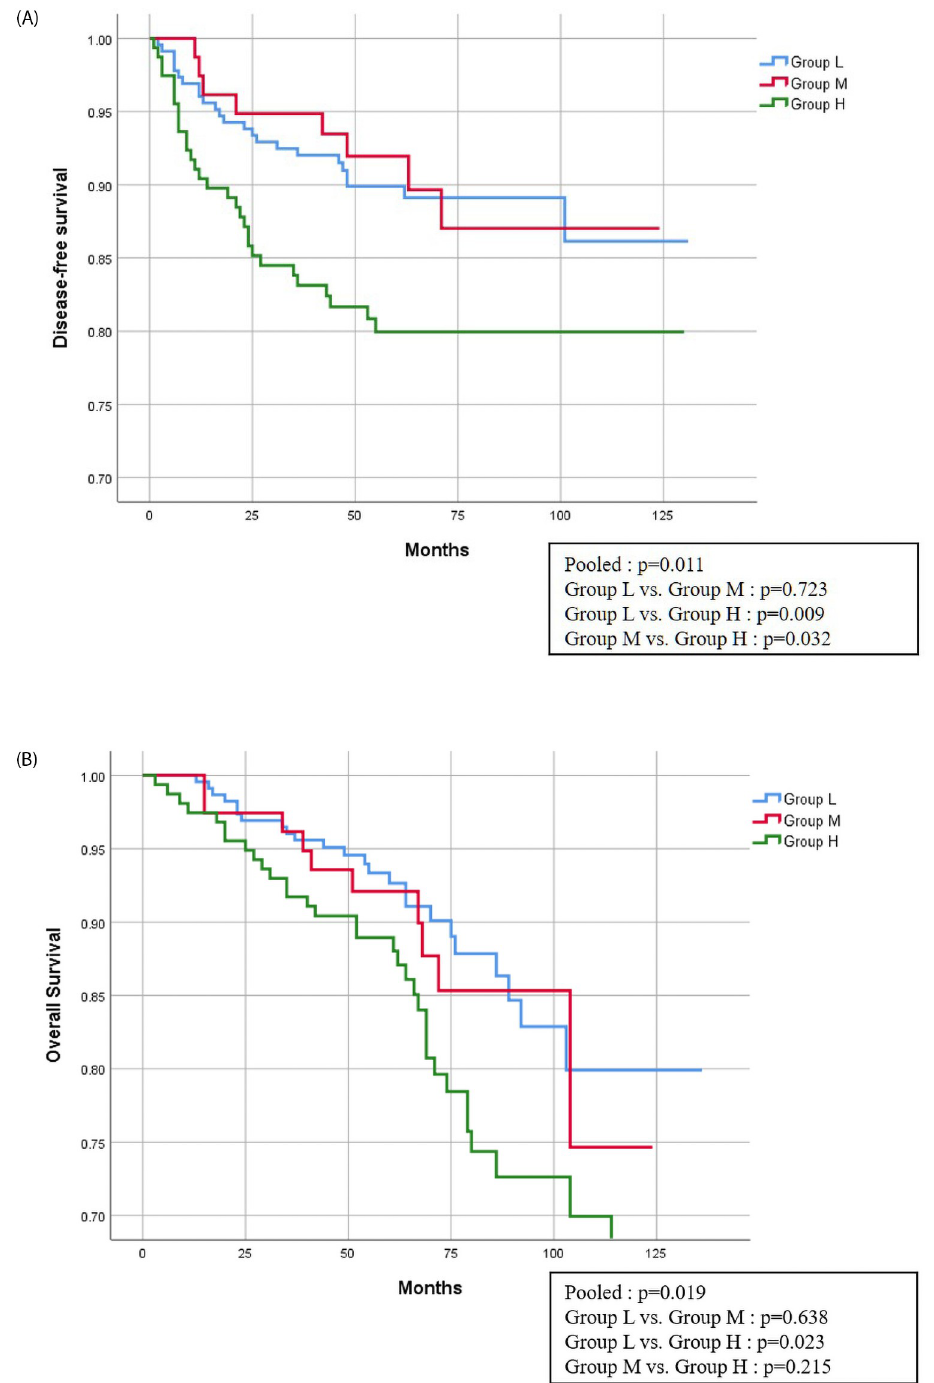
Fig 1. Disease-free survival and overall survival between groups.